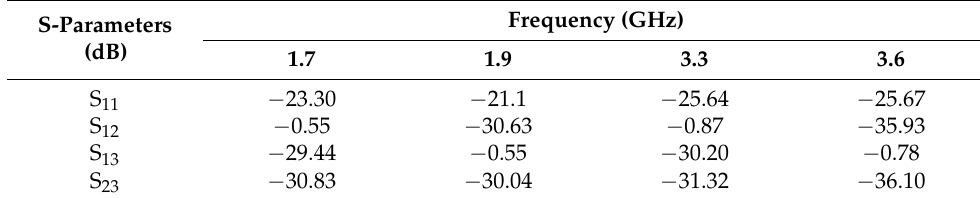
Table 2. Scattering parameters of the designed device.